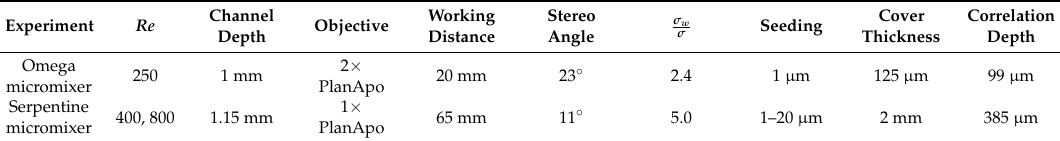
Table 4. Settings for the passive micromixer